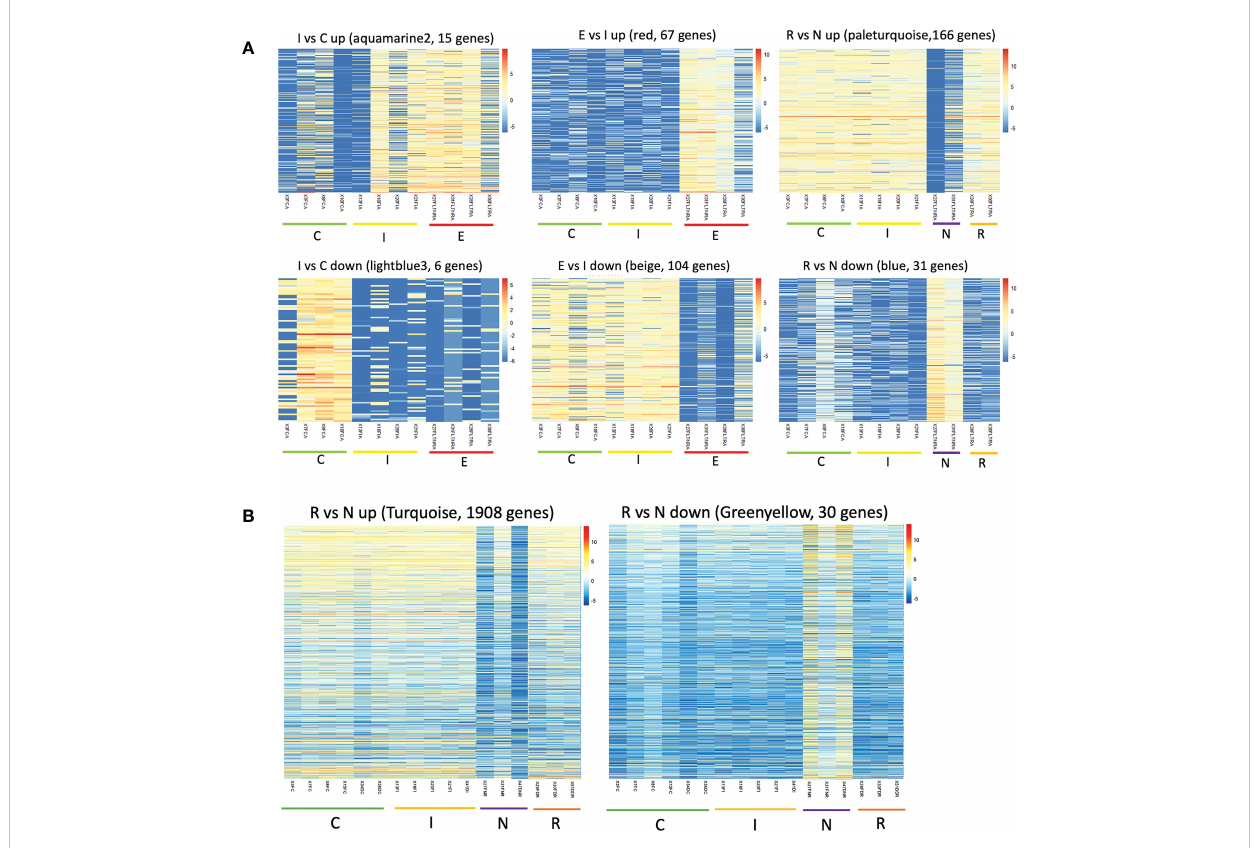
FIGURE 8 Heatmaps showing gene expression levels of the genes within the modules across three treatments (C, I, E) and responses (R, N). Warm colours represent up-regulated genes whereas cold colours represent down-regulated genes. The six modules that showed expression patterns related to the treatment/response are represented for Fiñana (A) , and the two modules related to the response for Fiñana + Dornajo (B)